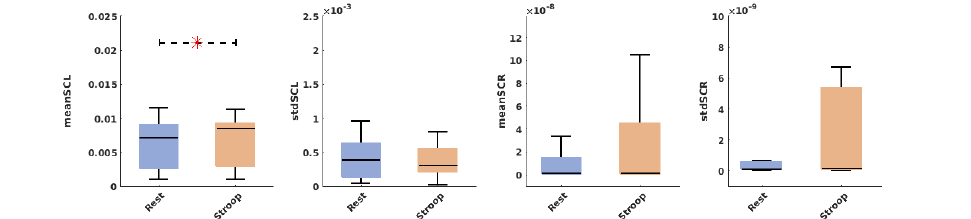
Figure 6. Results from the Wilcoxon sign-rank test considering the EDA-derived features. Statistically significant comparisons resulting in p < 0.05 are highlighted with